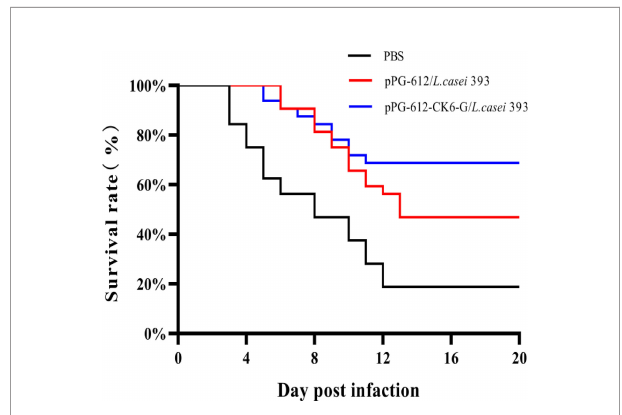
FIGURE 7 | IHNV was injected on the 60th day after re-immunization, and the survival rate curve of oral pPG-612-CK6-G/ L.casei 393 and the control group was observed within 14